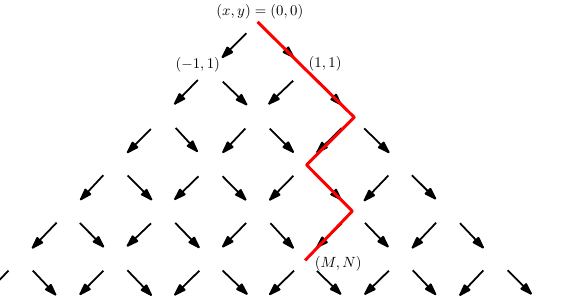
Figure 1. Example of an unrestricted path in L (( 0,0 ) → ( M , N )) for lattice L and set of steps S